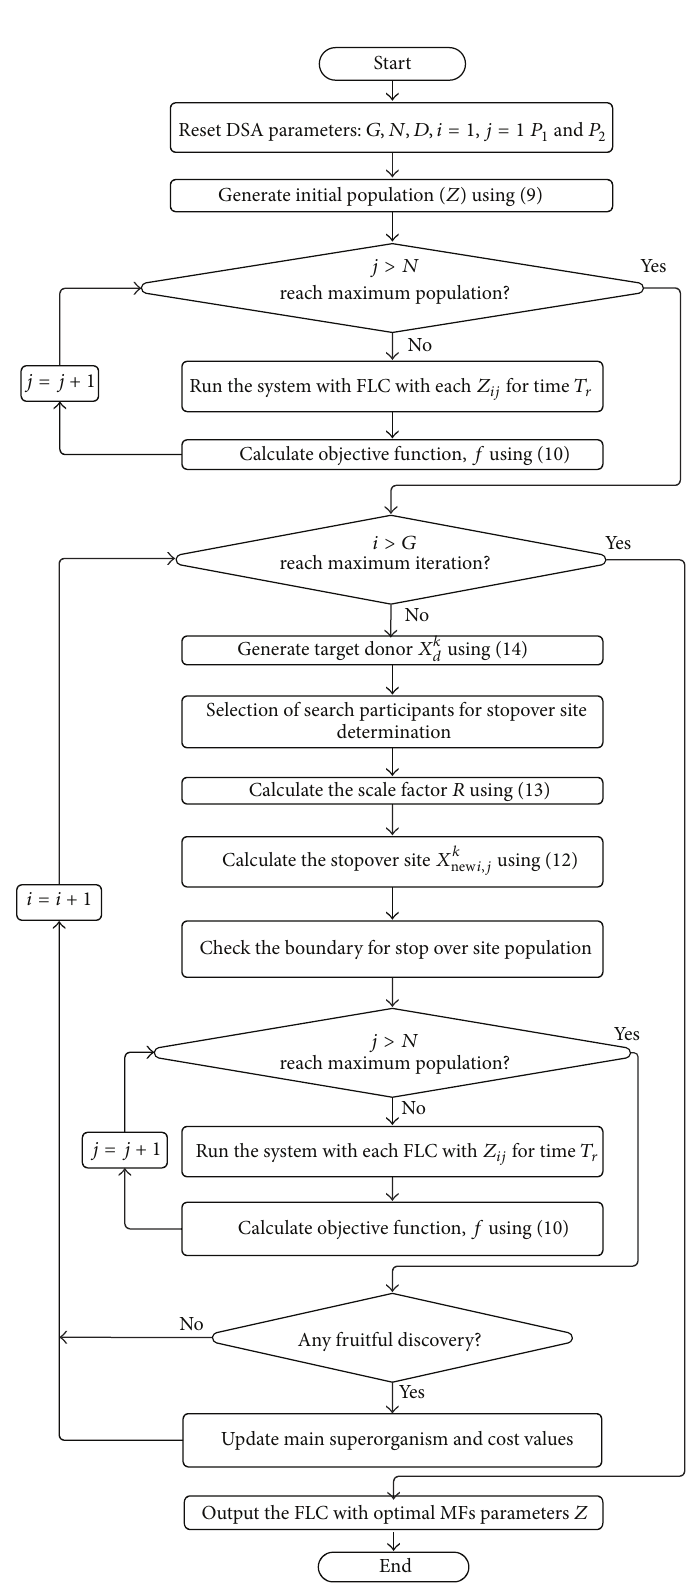
Figure 7: Proposed DSA based optimum FLC design